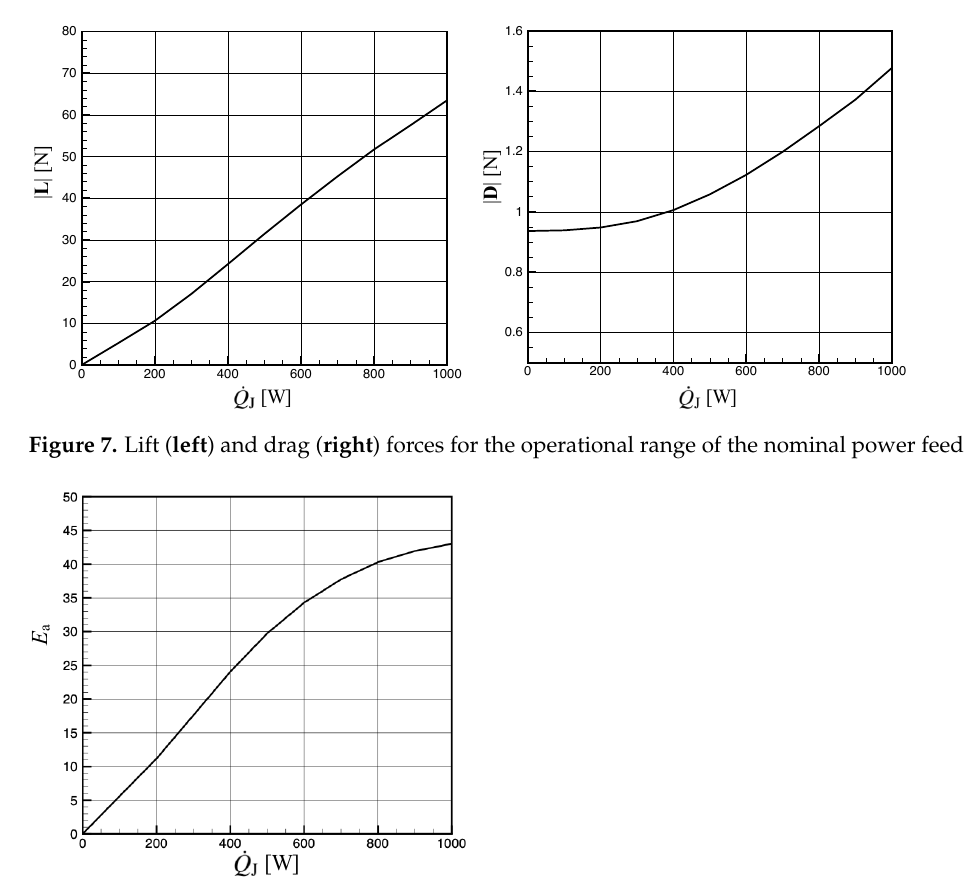
Figure 8. Aerodynamic efficiency for the operational range of the nominal power feed ˙ Q J